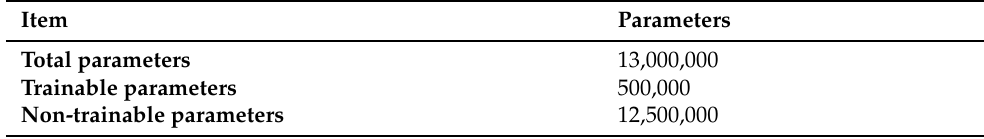
Table 1. VGG-16 network model parameters.